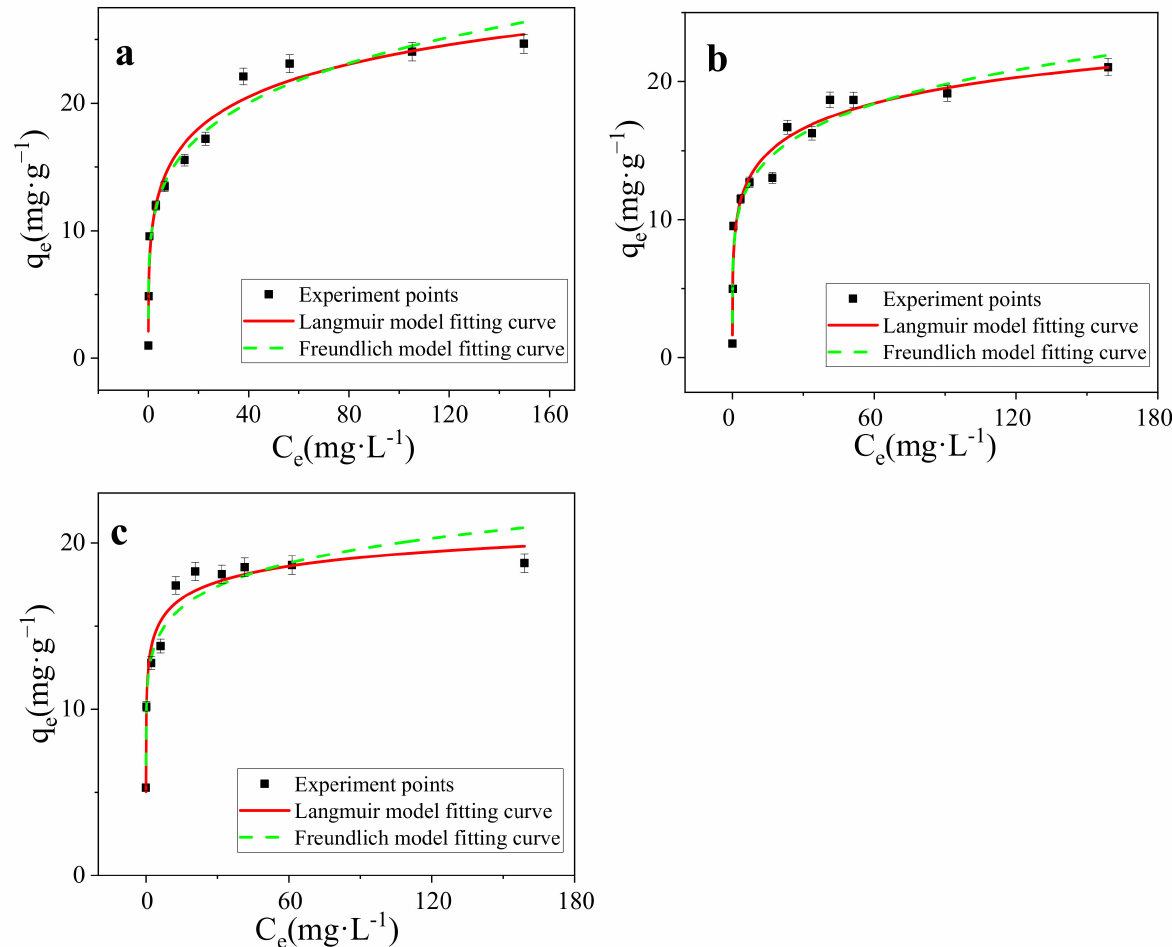
Figure 7. ( a ) Isotherm models of SMB (298 K), ( b ) Isotherm models of SMB (308 K), ( c ) Isotherm models of SMB (318